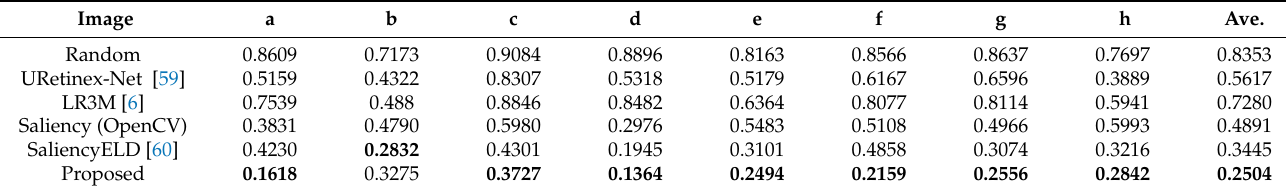
Table 1. Probability that the points are out of the object (8-bit luminance value threshold: 50). Probability of random sampling points is the percentage above or below the threshold. The other probabilities are the percentage of cases where the dithering points of the input image are above or below the threshold. The top score for each image is shown in boldface.